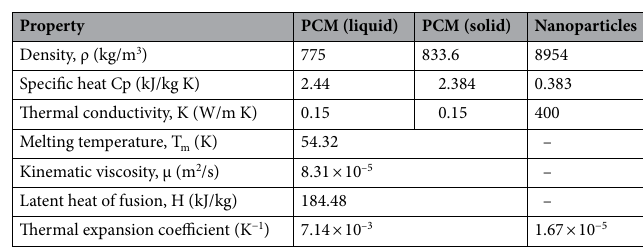
Table 1. Lists the characteristics of both nanoparticles and the PCM.